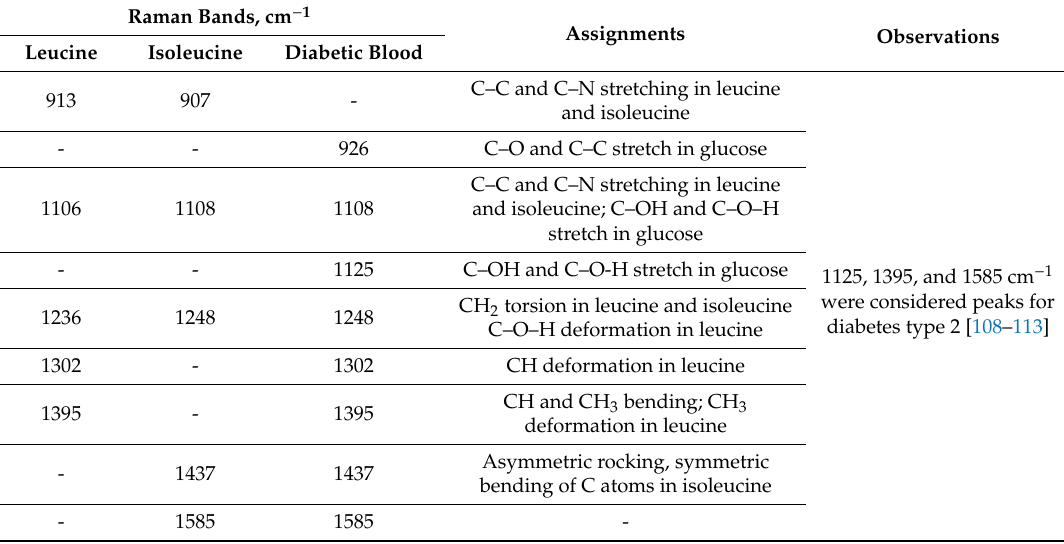
Table 2. Raman wavenumbers of diabetic Sprague Dawley rat